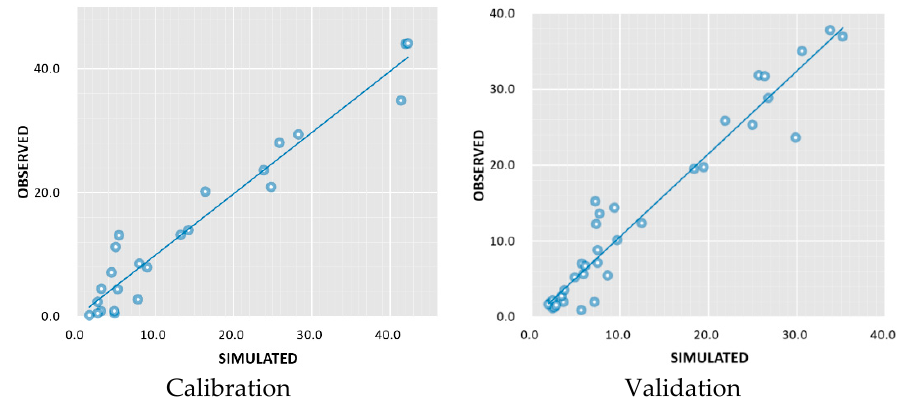
Figure 4. Deterministic coefficients of the monthly observed and simulated runoff of Jinghe mountain station.